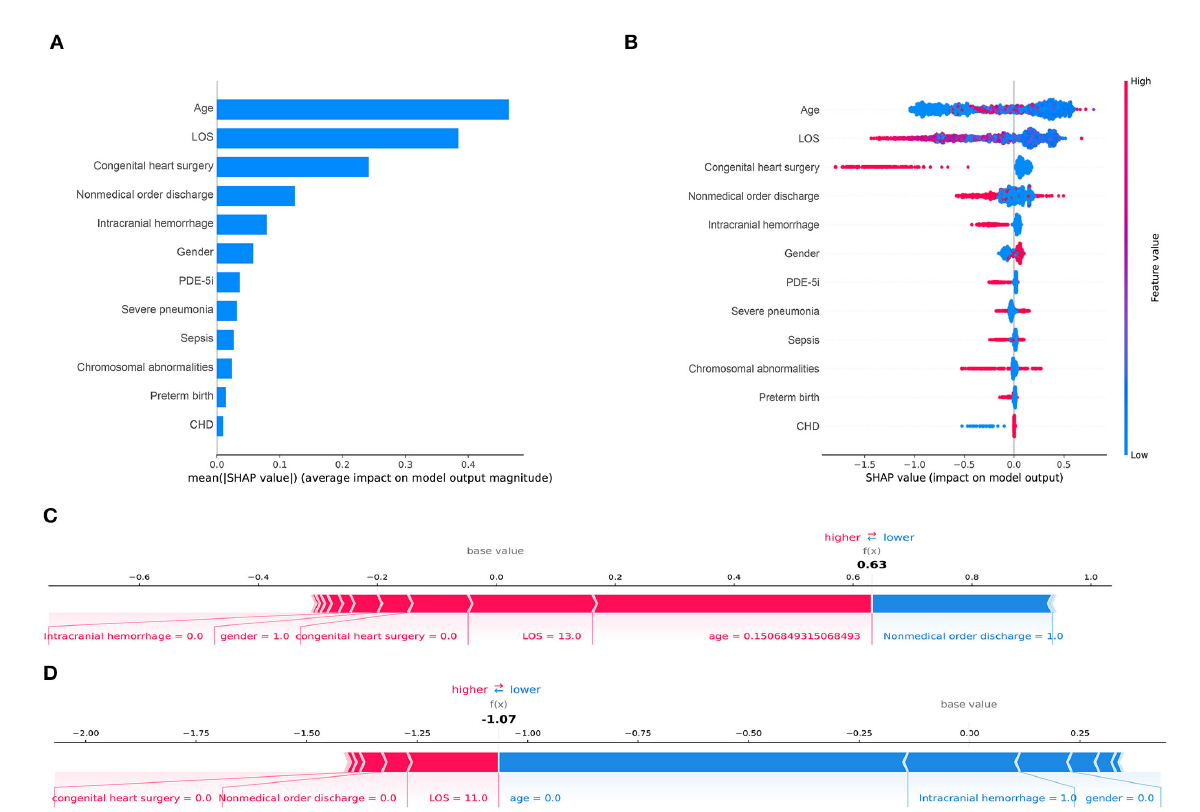
FIGURE5 Shapley Additive Explanations (SHAP) for the CatBoost model. (A) shows the most impactful features on prediction (ranked from most to least important). (B) shows the distribution of the impacts of each feature on the model output. Within each row, each dot represents a patient. The colors of the dots represent the feature values: red for larger values and blue for lower. (C, D) show the individualized predictions for two patients. The bars in red and blue represent risk factors and protective factors, respectively; longer bars represent greater feature importance. LOS, length of stay; PDE-5i, phosphodiesterase 5 inhibitors; CHD, congenital heart